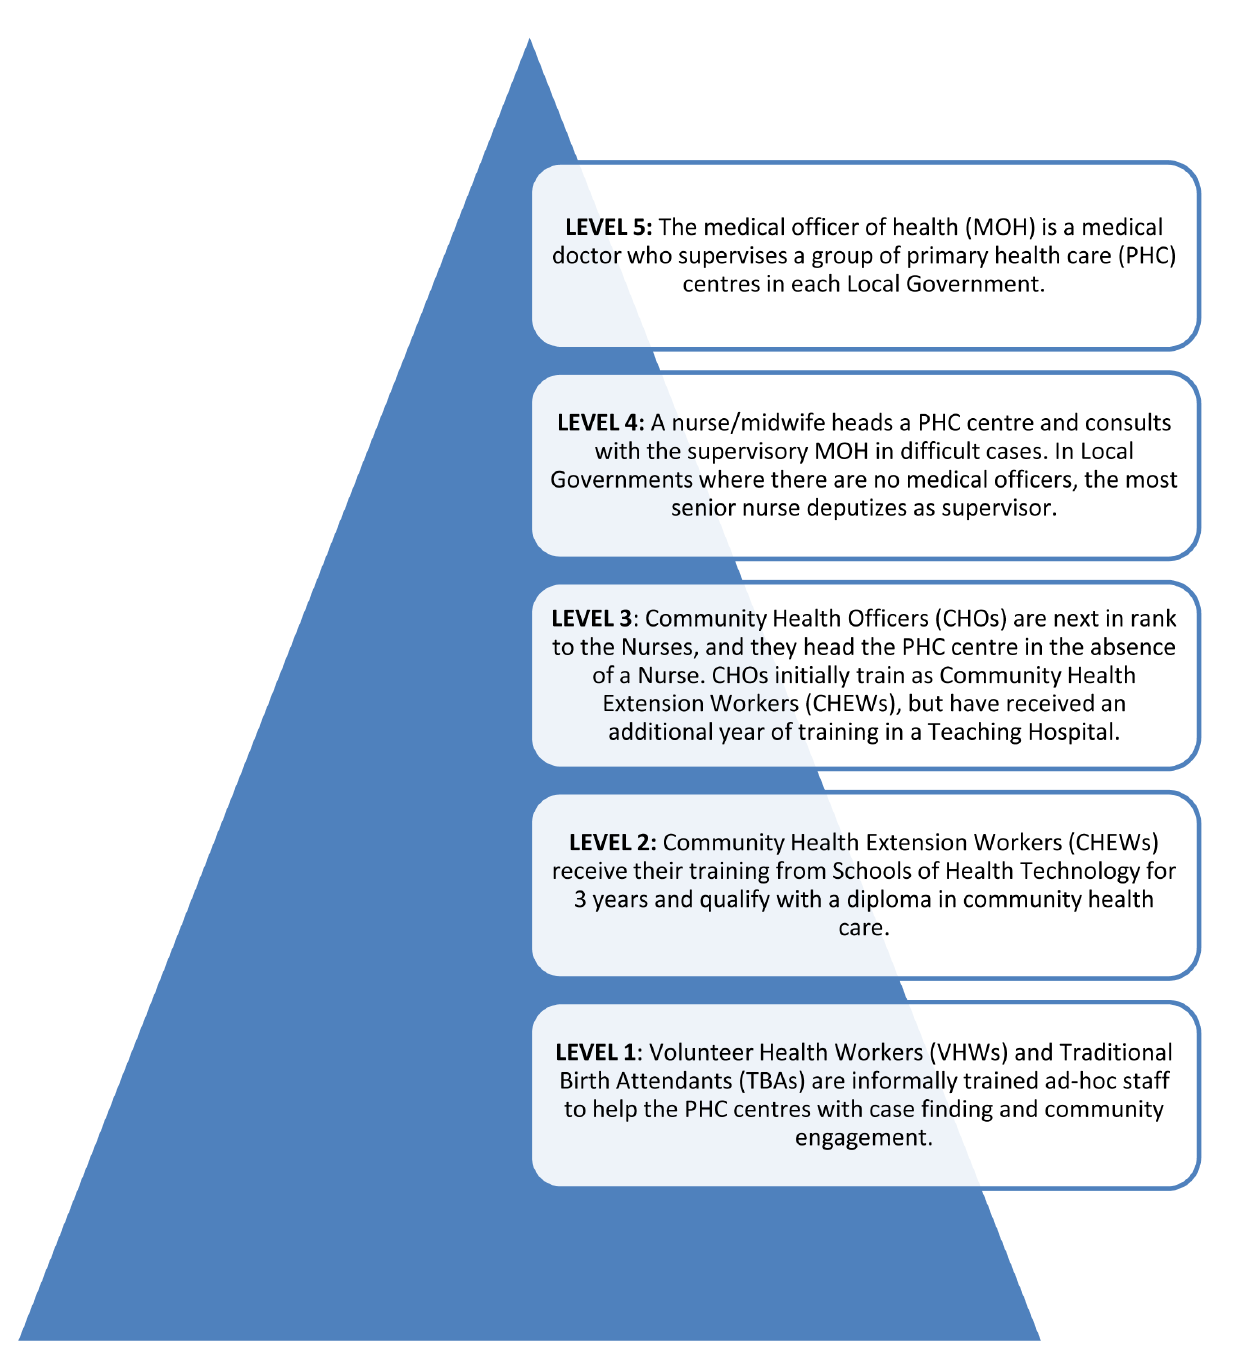
Figure 2. Organizational structure of the Nigerian primary health care system.